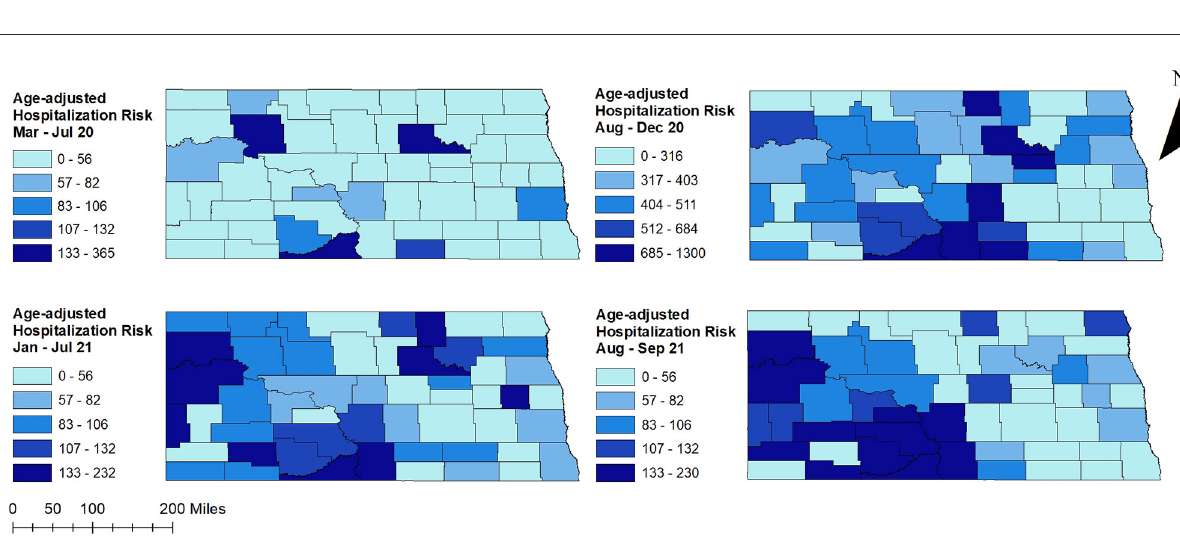
Completely rural (100% of county population live in rural areas) (Figure 1)